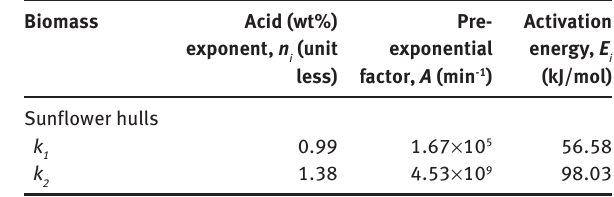
Table 6 Fitted Arrhenius parameters [Eq. (6)] obtained using the kinetic constants of Table